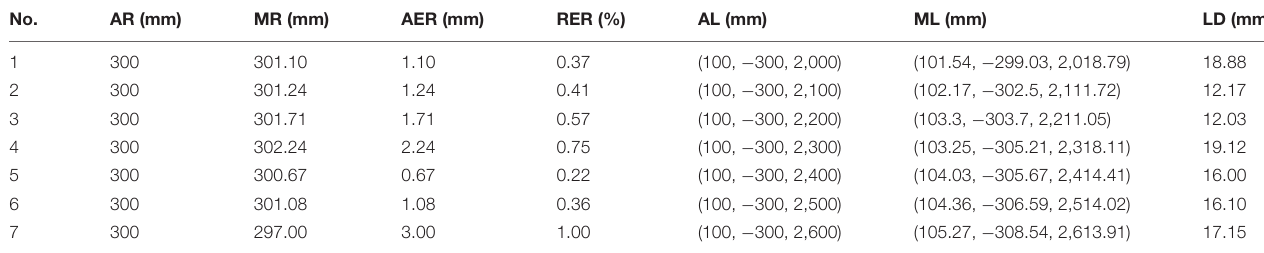
TABLE 2 | Laboratory test results of center coordinate and its radius.